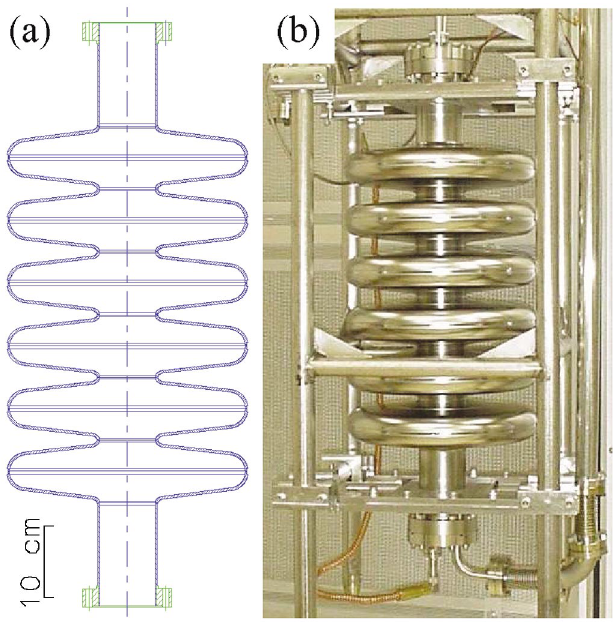
(cid:7) 0 : 47 cavity g